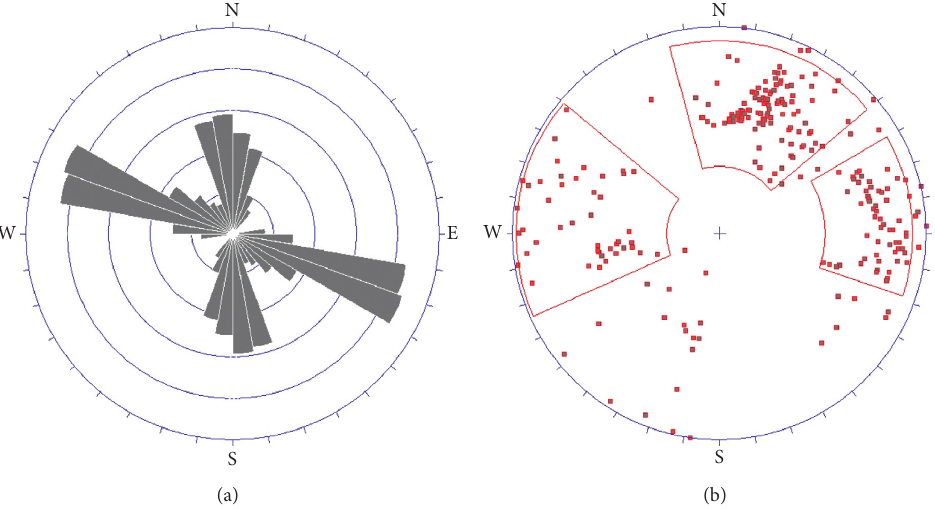
Figure 1: Joints distribution at Anqian open-pit iron mine: (a) rose diagram of joint and (b) pole distribution.